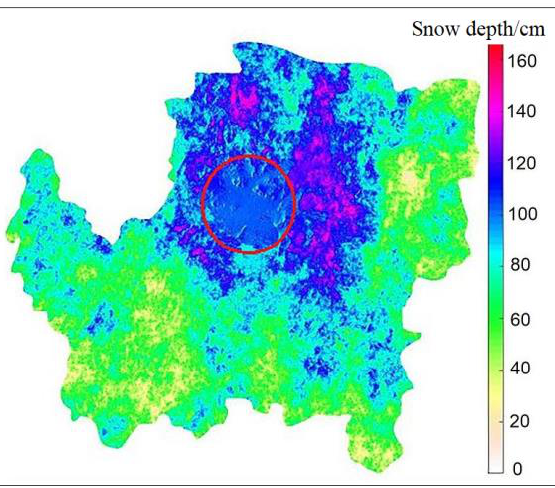
Figure 11. Snow depth inversion results. The red circle area corresponds to the urban area of Jiagedaqi.